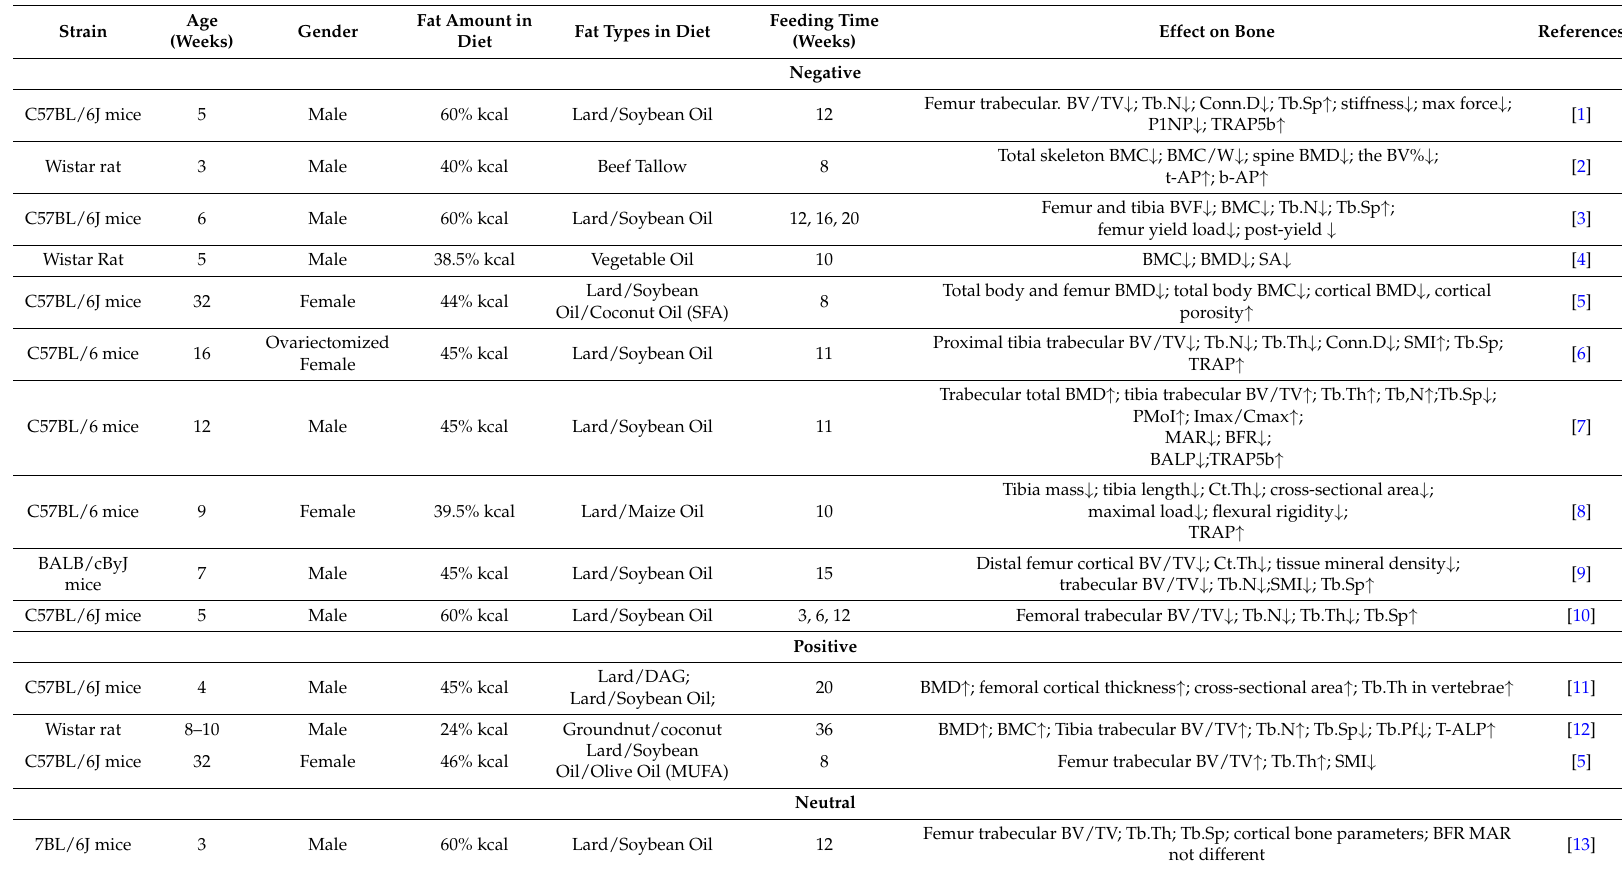
Table 1. Effect of fat diet on bone